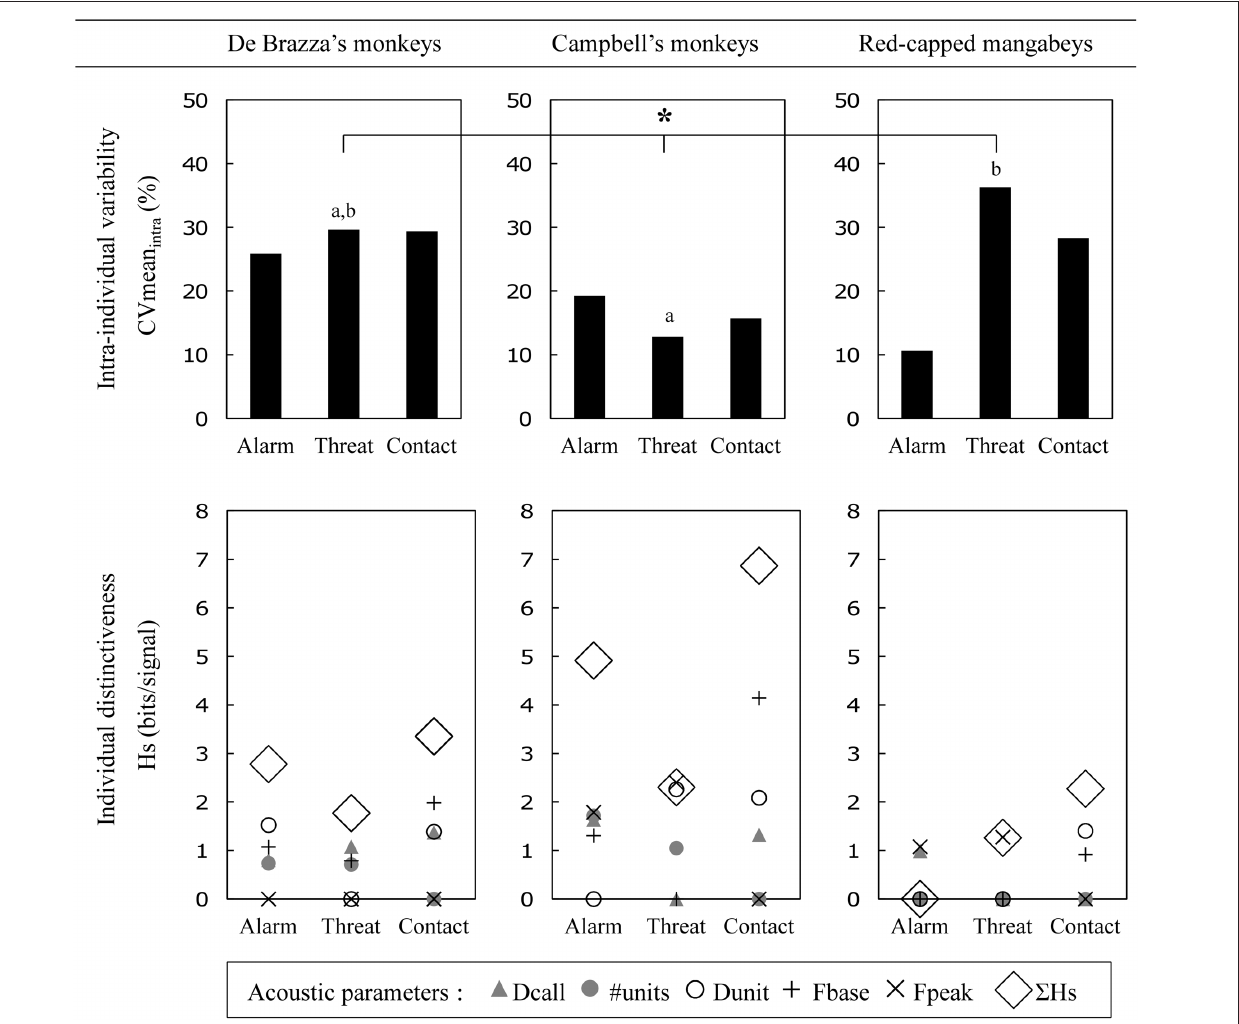
FIGURE 2 | Acoustic intra-individual variability and individual distinctiveness in contact, threat and alarm calls in each of three species of primate. CVmean intra : call type intra-individual coefficient of variation (%) and Friedman test result ( ∗ P < 0 . 05; results of the post-hoc multiple comparisons are illustrated by